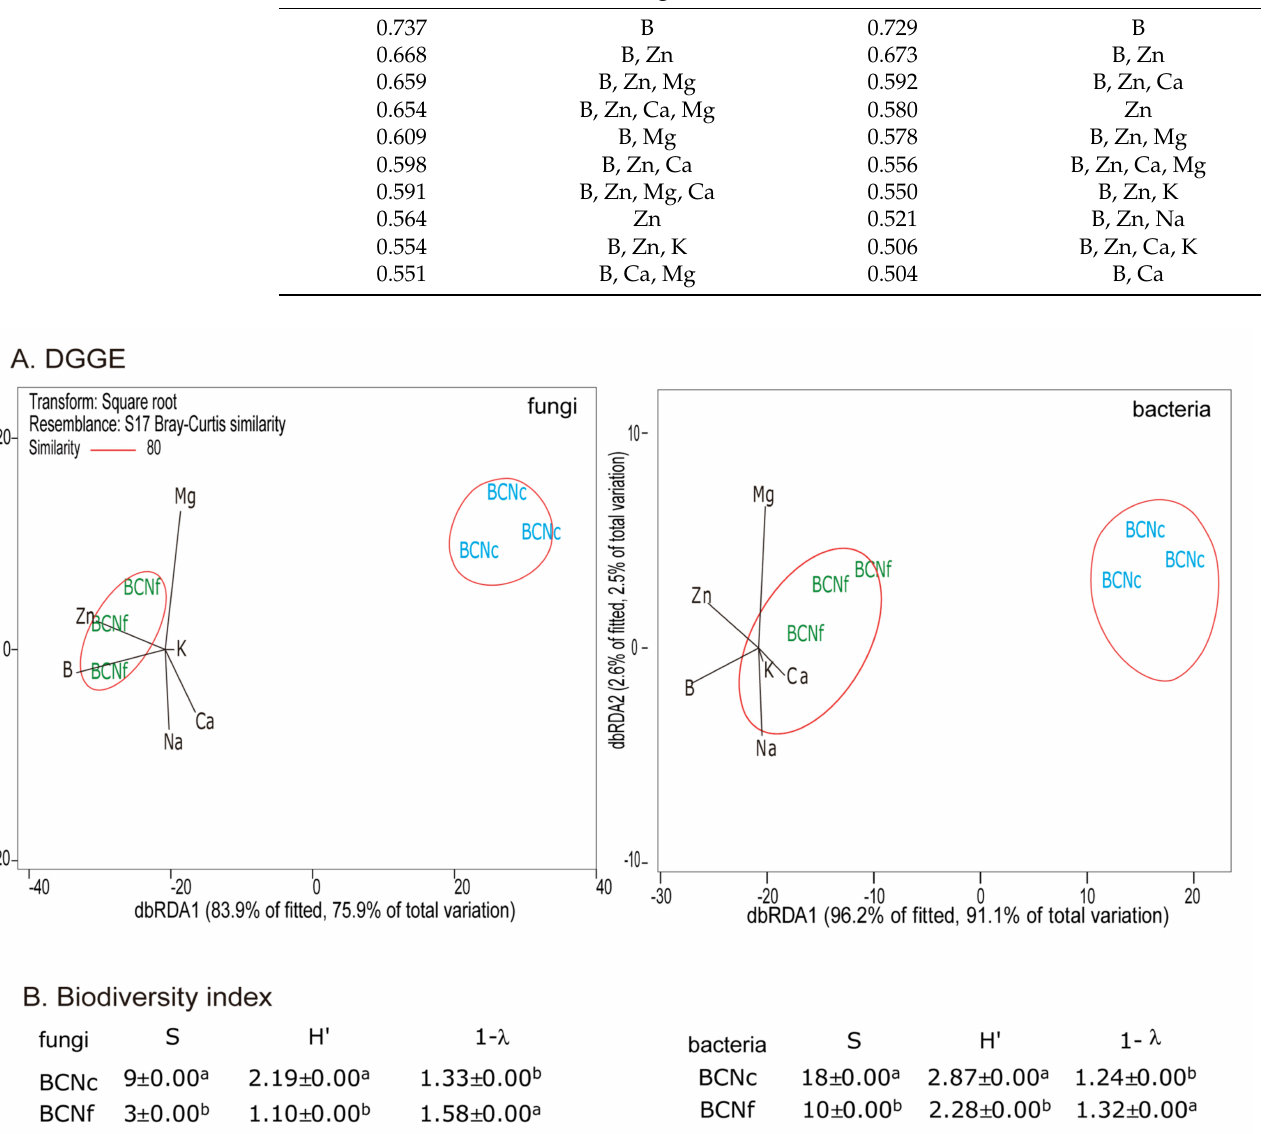
Figure 1. ( A ) Non-metric multidimensional scaling (NMDS) analysis of fungal (left) and bacteria (right) communities in fertilized nuts (green letters) and non-fertilized nuts (blue letters) from cv Barcelona. ( B ) Biodiversity indexes expressed as S (species number) Shanon–Wieneer (H (cid:48) ), Simpson (represented by 1 − λ ) of BCNc and BCNf. Tukey test was used to compare treatments means; values followed by the same letter do not differ at p < 0.05 ( n =